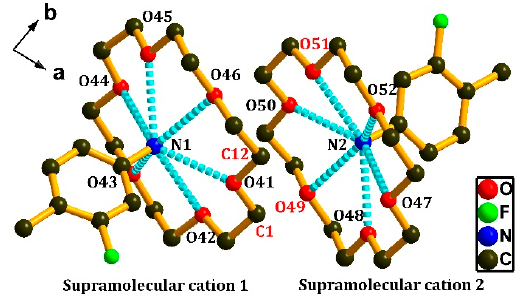
Figure 1. The structure of supramolecular cations in Crystal 1 . Hydrogen atoms are omitted for clarity, and dotted cyan lines represent hydrogen bonds. Table 2. H-Bond distances (Å) between N and O atoms in the supramolecular cation of Crystal 1 .